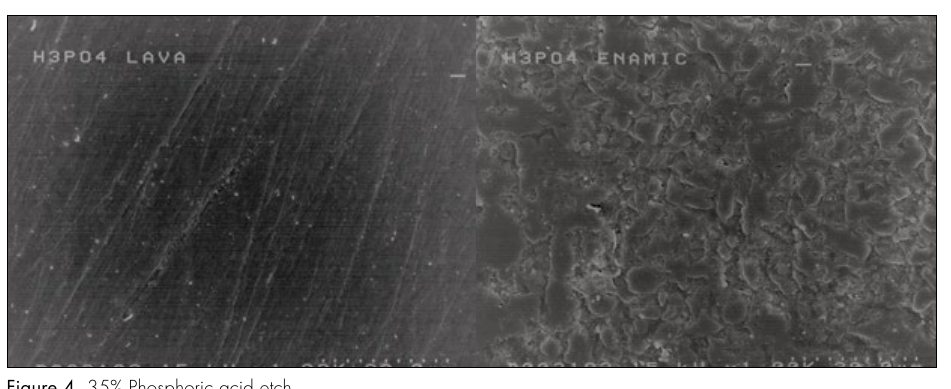
Figure 4. 35% Phosphoric acid etch.